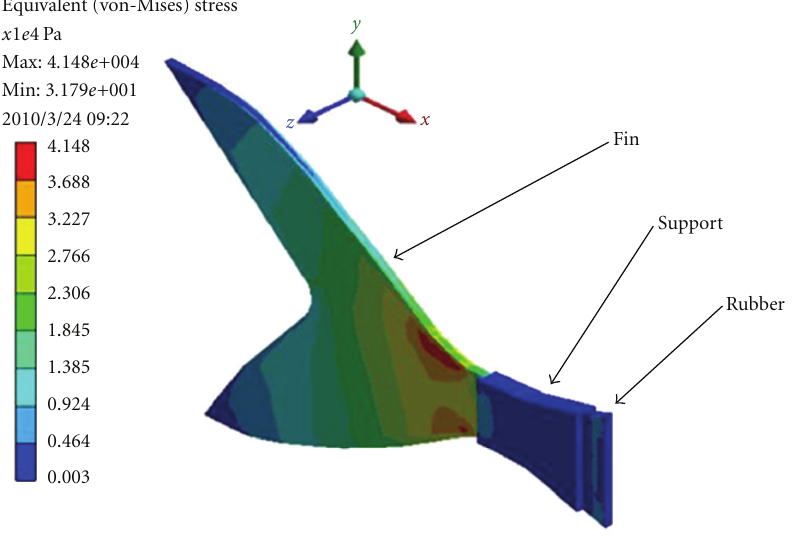
Figure 25: Simulation result—von-Mises stress acting within the peduncle using the simulated loads.